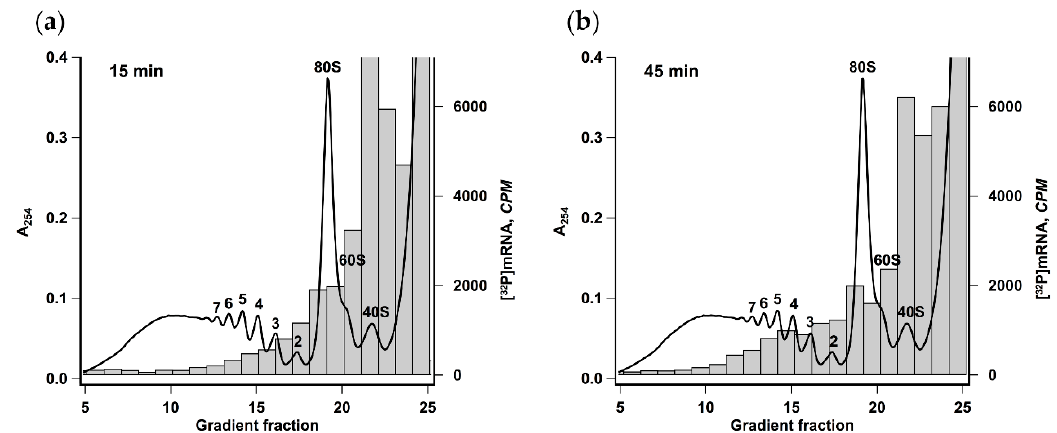
Figure 2. Size of polyribosomes increases in the course of translation. Krebs-2 system translating [ 32 P] β gloFlucA50 mRNA was fractionated by centrifugation in 12 mL 15–45% sucrose gradient after 15 min ( a ) or 45 min ( b ) of translation reaction. Radioactivity of 0.5 mL fractions was measured by Cherenkov counting. The absorbance curve representing polysome distribution in HEK293T cell lysate fractionated under the same conditions is given as a reference. Numbers indicate the size of polyribosomes in the corresponding peak.